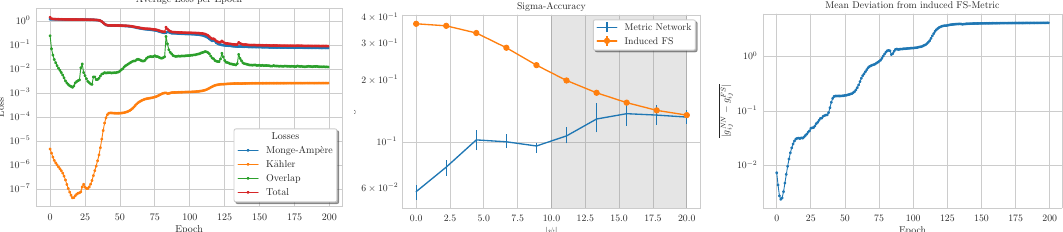
Figure 6 . ( Left ): evolution of the validation loss components for our network trained on the range 0 < | ψ | < 10 . The loss components are averaged over the respective patch-networks. ( Middle ): σ accuracy of our network in comparison with the induced Fubini-Study accuracy. The data points indicate the mean value of the performance, and the error bars show the minimal and maximal accuracy on different patches. (We have multiple networks which are trained here.) This average is also over four different angles θ for ψ = re iθ , namely 0 , π/ 2 , π , and 3 π/ 2 . The networks were trained on values of | ψ | < 10 , and the performance in the range 10 < | ψ | < 20 is obtained from extrapolation beyond the training set. ( Right ): deviation from the induced Fubini study metric during training, averaged over each patch-network and across the ψ values used for